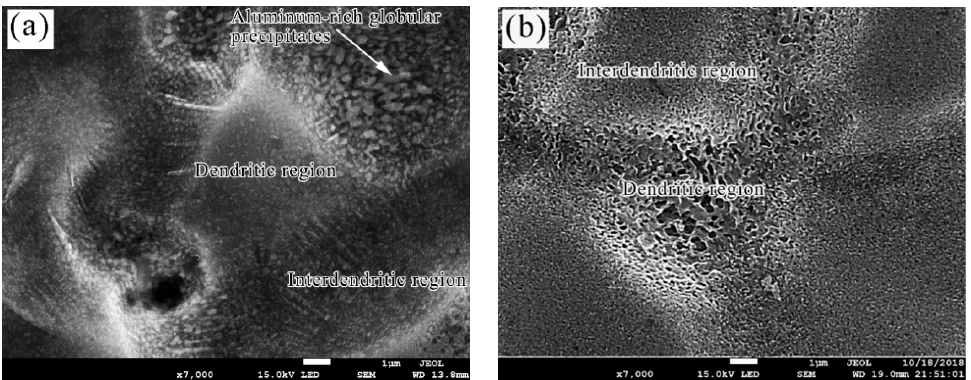
Figure 4. SEM micrograph of ( a ) bare Zn55Al surface and ( b ) Zn55Al surface pre-treated by pickling and alkali washing.